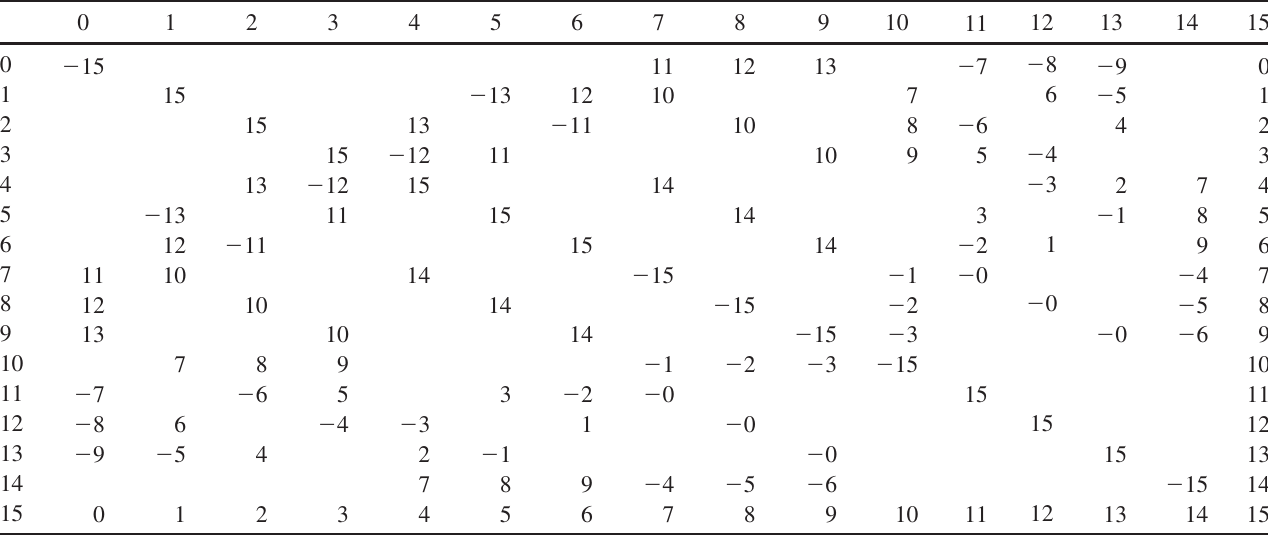
TABLE V. Anticommutator table of the group of (cid:1) matrices: (cid:1) column, and c the table